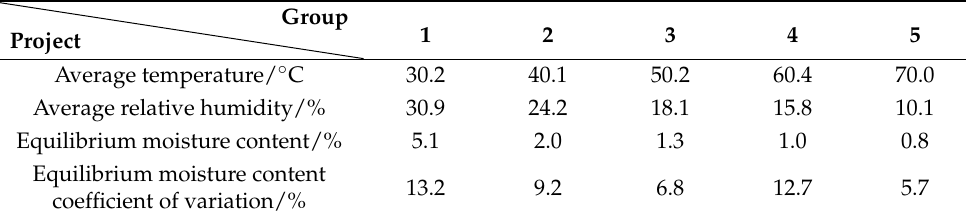
Table 7. The equilibrium moisture content of the specimens under different test